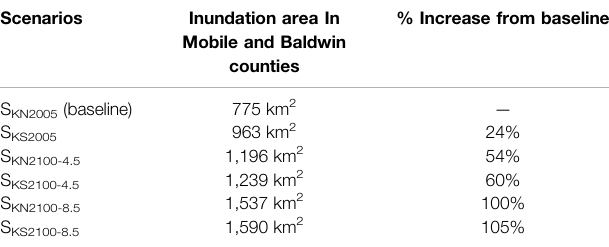
The extent of peak stormsurge fl ooding for each scenario in Table 1 is shown in Figure 12 . Comparing fl ooding between the natural and shifted track, the area inundated by the shifted track (blue color in Figure 12B ) is 24% larger than the area inundated by the natural track